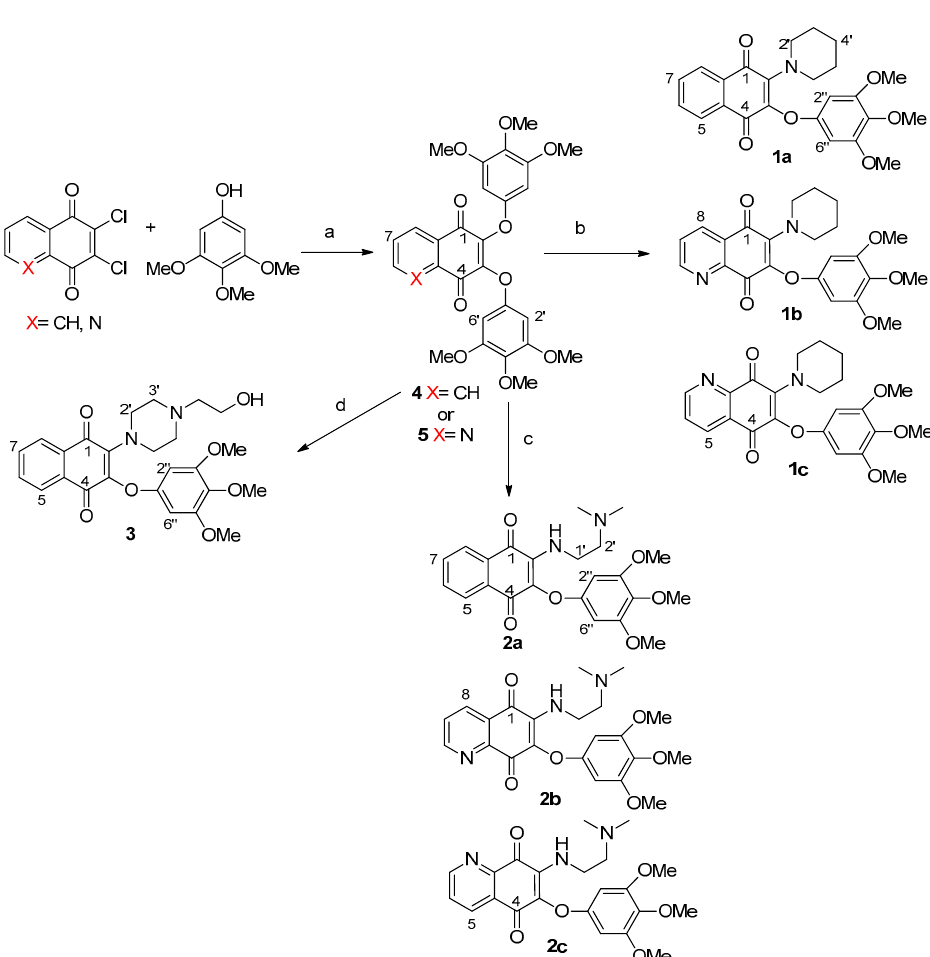
Figure 1. Design strategy of the target hybrid molecules.